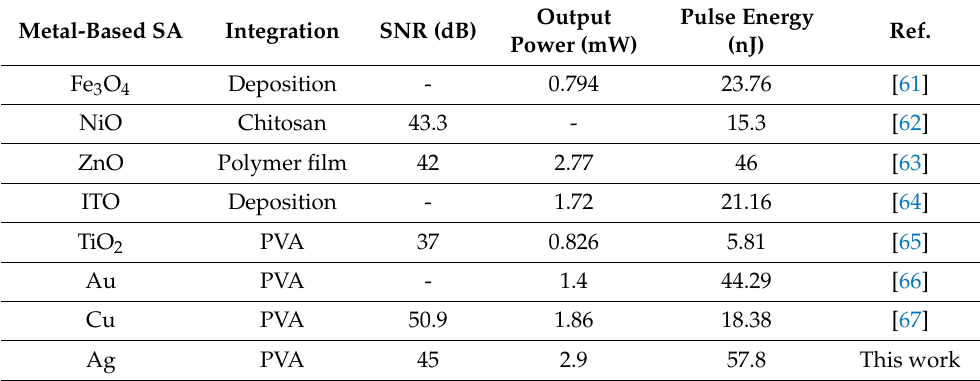
Table 1. Comparison of Q-switched EDFL enabled by different metal-based